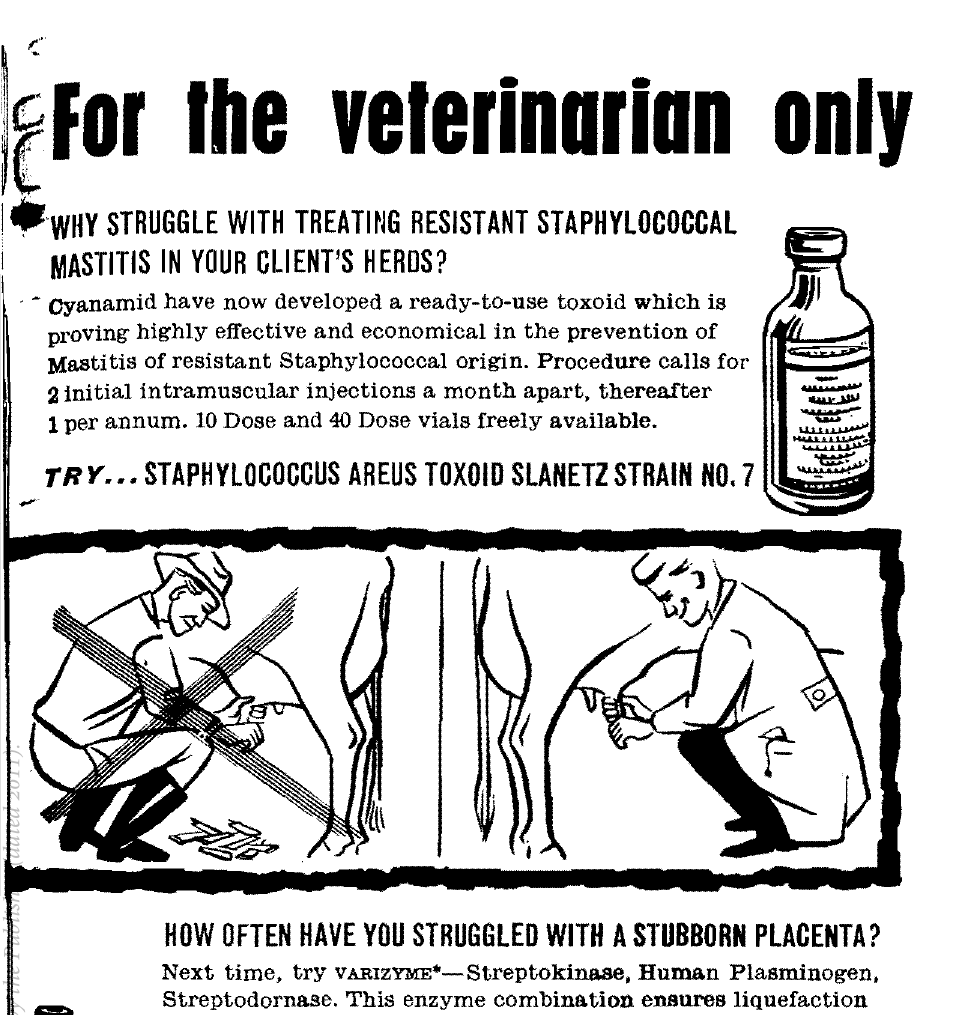
. - Oyanamid have now developed a ready-to-use toxoid which is proving highly effective and economical in the prevention of Mastitis of resistant Staphylococcal origin. Procedure calls for 2 initial intramuscular injections a month apart. thereafter 1 per annum. 10 Dose and 40 Dose vials freely